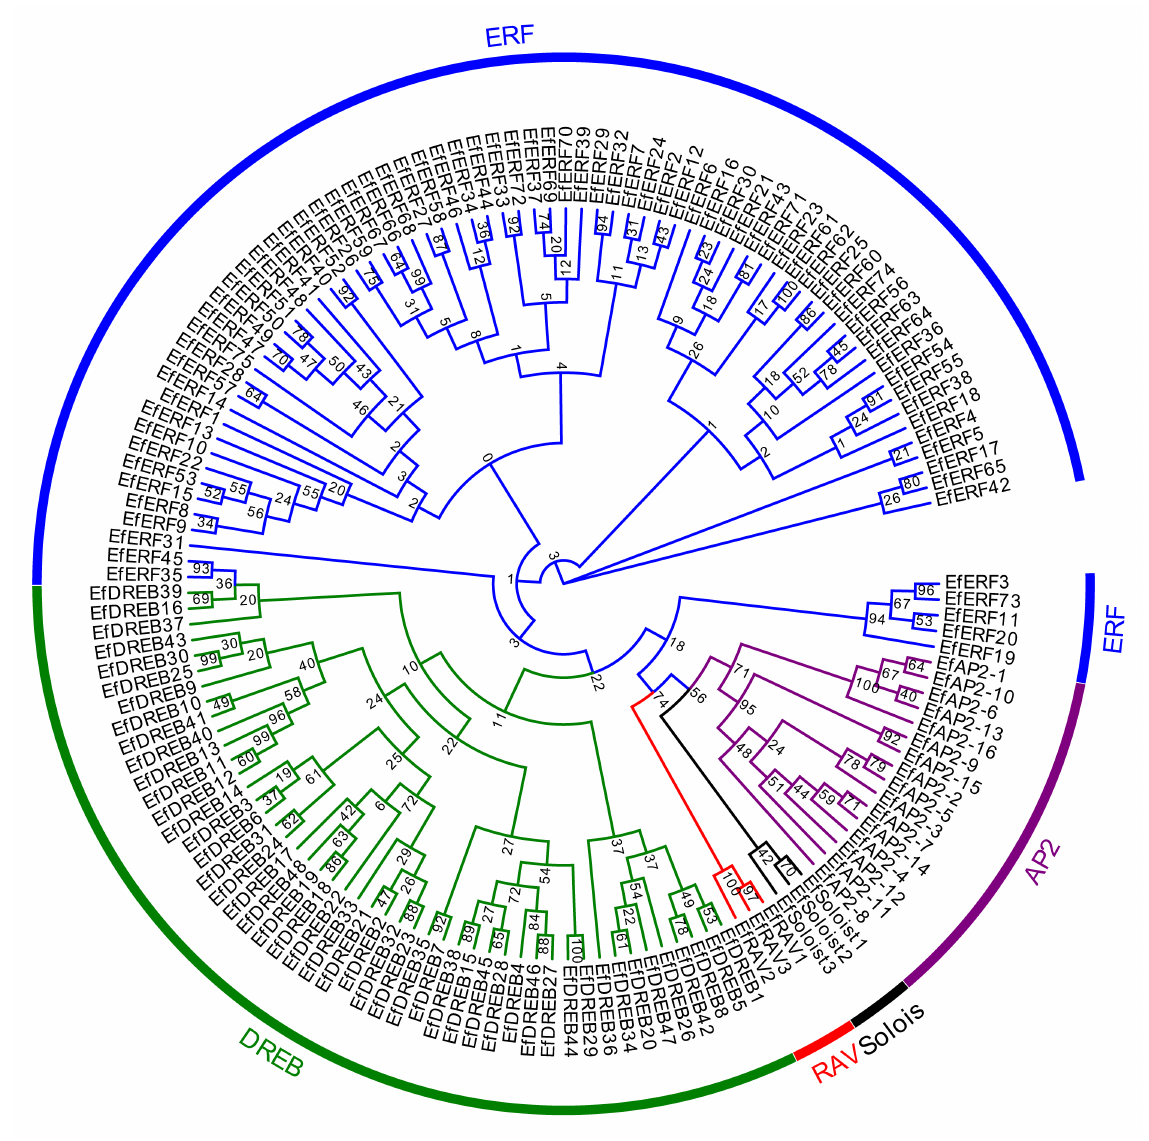
Figure 1. Phylogenetic tree of AP2/ERF family genes in E. fulvus . The phylogenetic trees clustered all of the EfAP2/ERF proteins into five subfamilies: the DREB, ERF, AP2, RAV, and Soloist subfamilies. Each subfamily is shown in a different